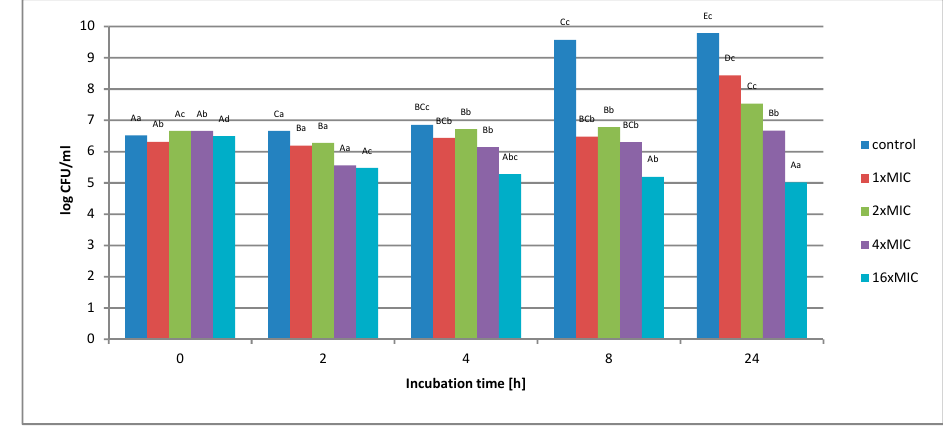
Figure 9. Effect of aqueous extract at a concentration of 1 × MIC, 2 × MIC, 4 × MIC, and 16 × MIC on